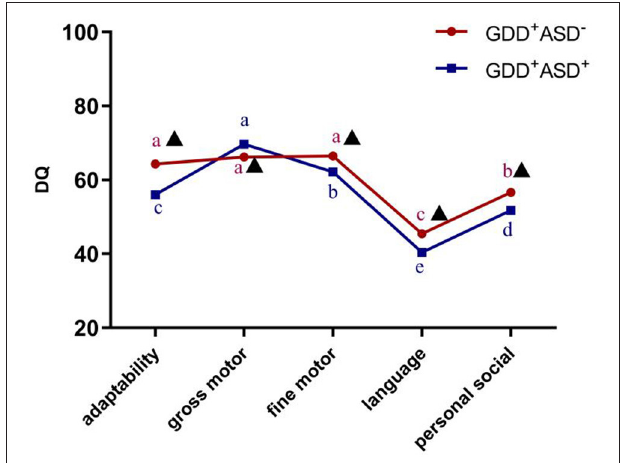
FIGURE 3 | Development profile of the Gesell Developmental Schedules in GDD + ASD − group and GDD + ASD + group. GDD, Global developmental delay; ASD, Autism spectrum disorder; DQ, developmental quotient; Mean values marked with different letter (a, b, c, d or e) indicate DQ scores in the five sub-domains of Gesell Developmental Schedules, and those with the same letter exhibit no statistically significant difference while different letters represent with statistical difference (comparison within the group); N Indicates that there is a significant difference between GDD + ASD − and GDD + ASD + group (comparison between groups); p < 0.05 indicated statistical